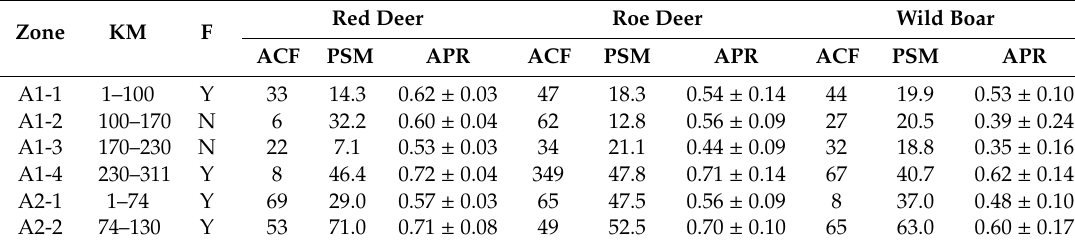
Table 4. Basic characteristics of the four movement zones of highway A1 and the two movement zones of highway A2 according the model: KM denotes position of the zone from the highway origin in Vilnius city center in km; F—presence of fences in the zone, as for 2007; ACF—average crossing frequency per km of the highway according the model; PSM—percent of all simulated movement; APR—average pathway rank ±